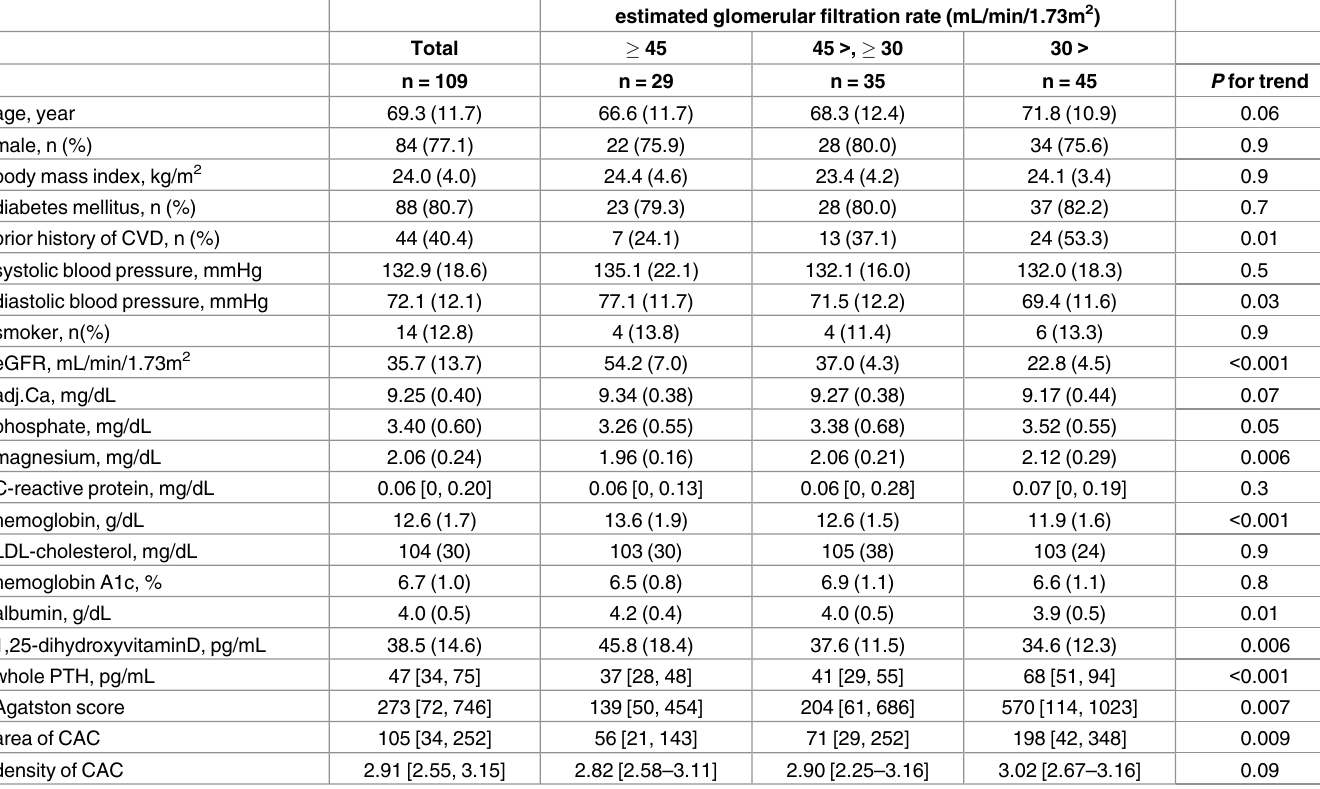
Table 1. Demographic and clinical characteristics of study